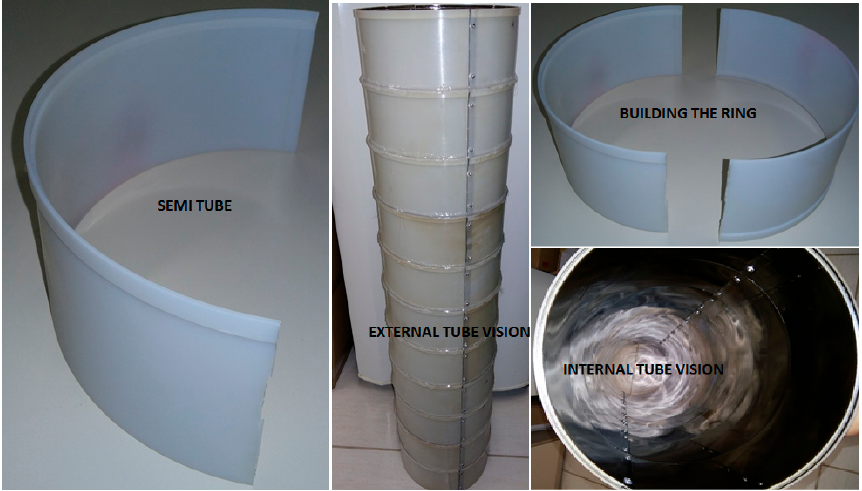
Figure 2. Prototype of the proposed system.